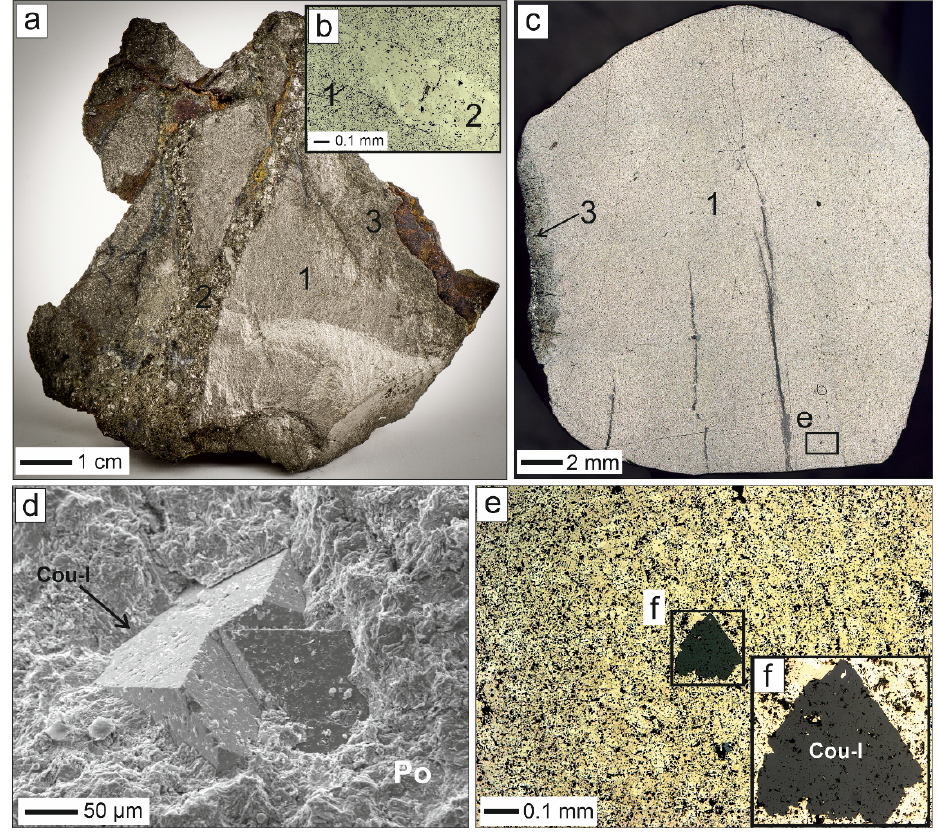
Figure 2. Coulsonite-I (Cou-I) in massive pyrrhotite ores of type I (mPo-I): ( a )—sample of mPo-I (1—the main mass of hexagonal and monocline pyrrhotite; 2—microveins of hexagonal pyrrhotite; 3—oxidation zone); ( b , c )—mPo-I in a polished section (reflected light images); ( d )—intergrowth of coulsonite crystals in mPo-I (SE image); ( e , f )—metacrystal of Cou-I in the main mass of pyrrhotite (reflected light images). The mineral abbreviations hereafter are according to [33], apart from those introduced by the author for rare minerals. SE—secondary electron.